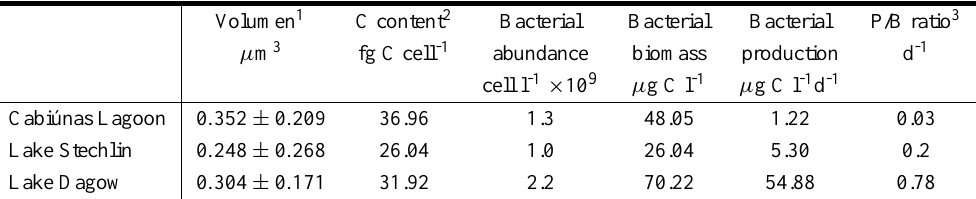
Bacterial biovolume, carbon content, abundance, biomass, production and P/B ratio in water samples from Cabiúnas Lagoon, Lake Stechlin and Lake Dagow. The values represent the average of the three stations (L1, L2 and P) ± standard